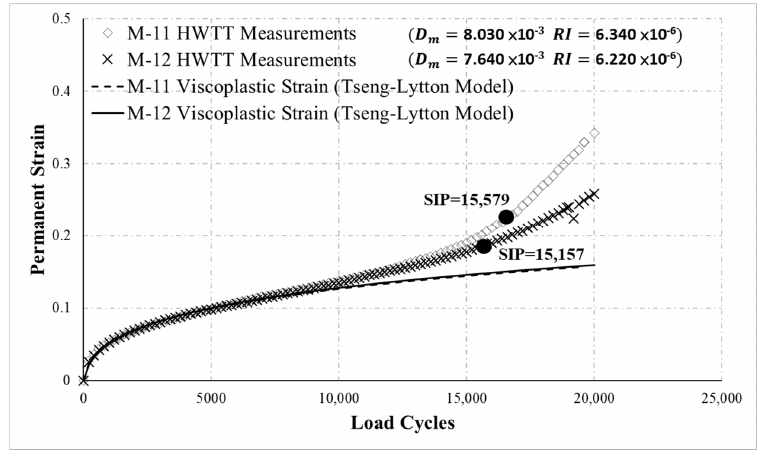
Figure 11. HWTT results for M-11 and M-12.